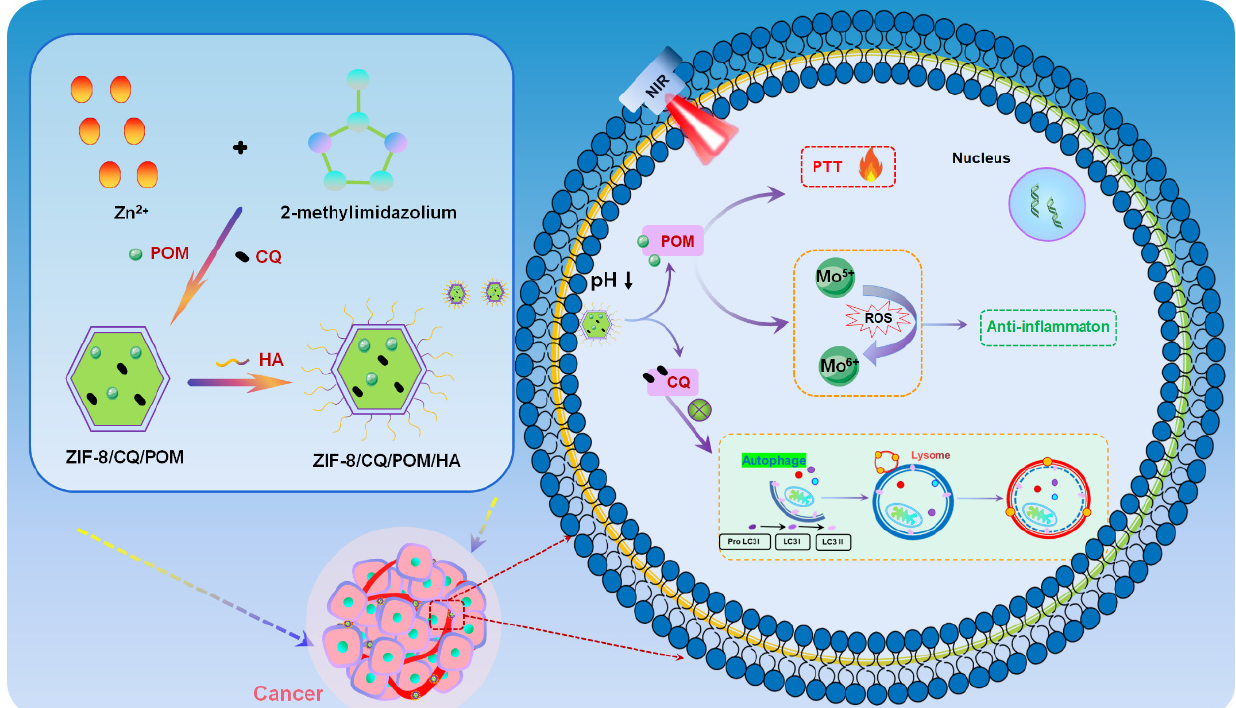
Figure 1. Schematic illustration of the synthesis of ZCPHs and the combined PTT/anti-autophagy/anti-inflammation of tumors.